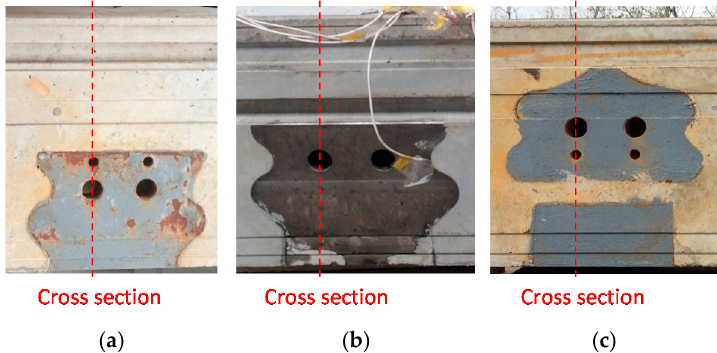
Figure 5. Front view of the DIJP configurations: ( a ) Type-BPos; ( b ) Type-A; ( c ) Type-BNeg.